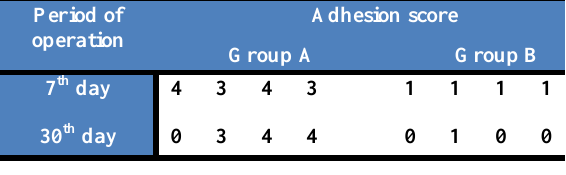
Table, 2: The adhesion scores in each animal (microscopic examination) at the 7th and 30th days post-operation for experimental groups. Period of Adhesion score operation Group A Group B 7th day operation 30th day operation Table, 3: Means± SE of scores for the two groups according to Zühlke scores of post-operation intraperitoneal adhesions . Group Group A Group B Period 7 days after operation